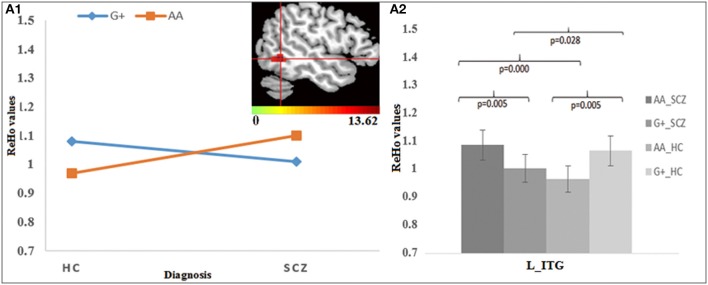
The interaction and simple effect between rs2738880 genotypes and diagnosis. (A1) Cluster of significance for the interaction effect in the L-ITG. (A2) The simple effect in the L-ITG.